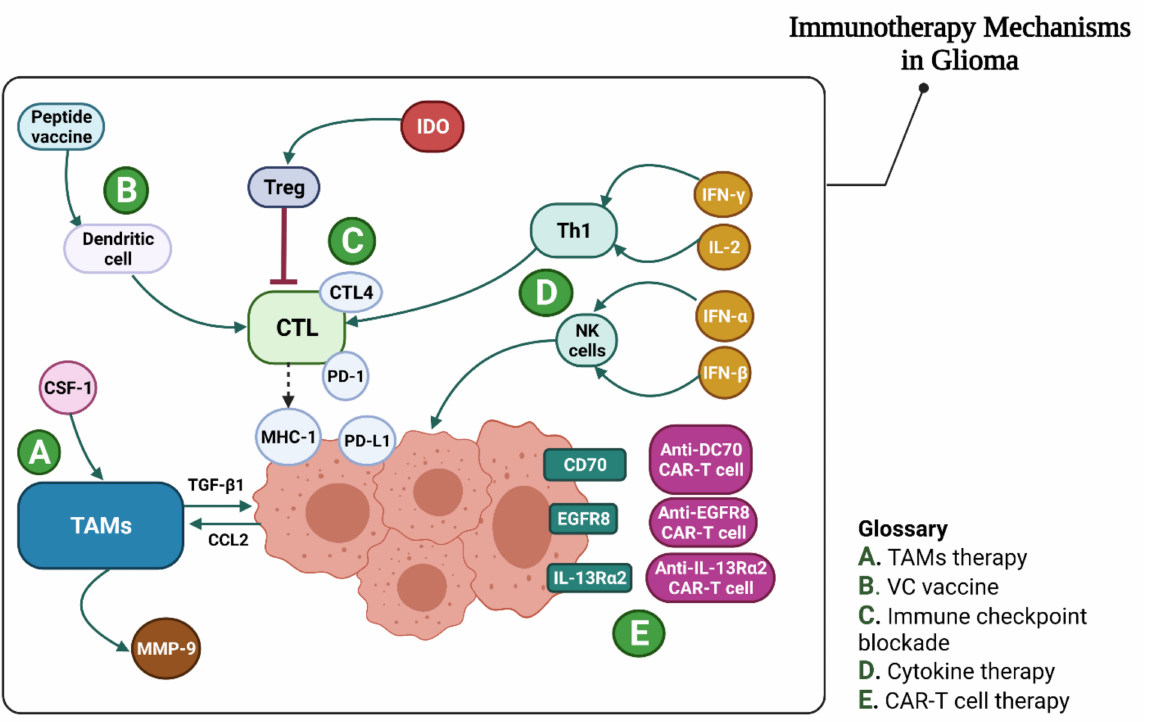
Figure 3. Current strategies for immunotherapy in glioma. DCs have a direct linkage to activating CTLs and to antigen presentation, thus killing glioma cells. PD-1, CTLA-4, and IDO as immune checkpoint ligands can be activated, which in turn lead to glioma cells escaping from immune